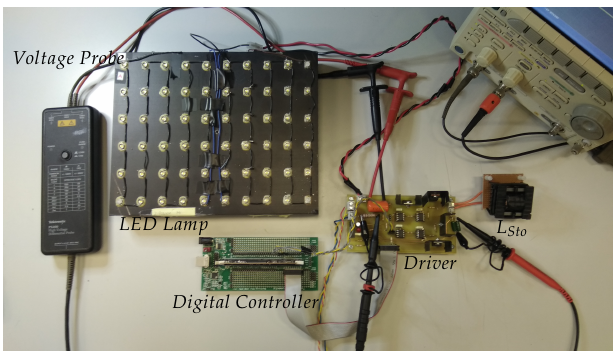
Figure 12. Experimental setup of the built prototype.